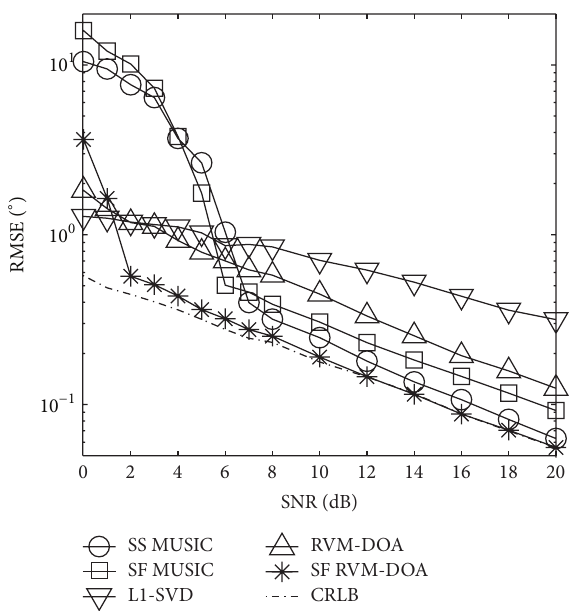
Figure 1: Averaged DOA estimation RMSE of two equal-power coherent sources separated by 10 ∘ with 30 snapshots when the SNR increases.